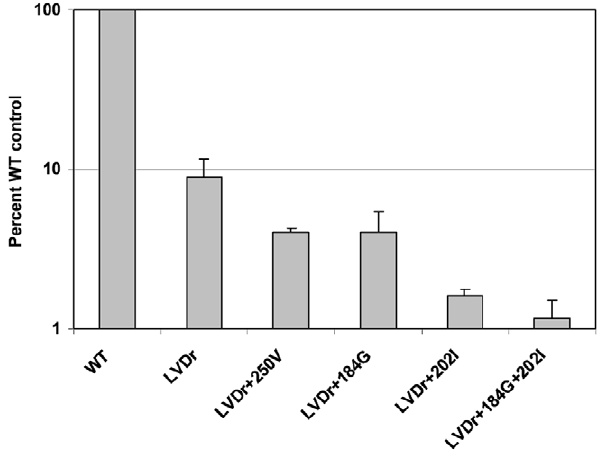
Figure 1. Incorporation of [ 3 H]-ETV into HBV nucleocapsid DNA in culture. [ 3 H]-ETV was added to cultures of HepG2 cells transfected with an HBV expression construct, as detailed under Materials and Methods. HBV nucleocapsids were isolated from cell lysates, as detailed under Materials and Methods, and radiolabeled HBV DNA was quantified through scintillation counting. The levels of nucleocapsid-associated [ 3 H] from cells grown in [ 3 H]-ETV are presented as percent wildtype control values 6 standard deviation. Yields of HBV nucleocapsid DNA were standardized according to real-time PCR quantification of HBV DNA within isolated nucleocapsids, as detailed under Materials and Methods. Similar results were obtained by standardizing total HBV nucleocapsid DNA levels with nucleocapsids from parallel cultures metabolically labeled with [ 3 H]-thymidine (data not shown). WT, wildtype nucleocapsids; LVDr, M204V + L180M substi- tuted HBV nucleocapsids, LVDr + M250V, M204V + L180M + M250V substi- tuted nucleocapsids; LVDr + T184G + S202I, M204V + L180M + T184G + S202I substituted nucleocapsids. HBVs were tested independently 3 to 4 times, except the LVDr + M250V, which was tested